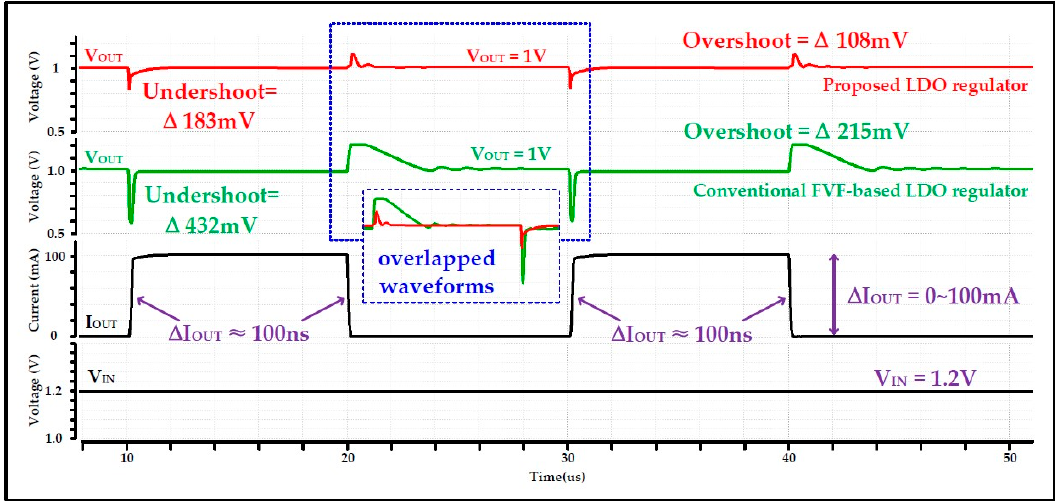
Figure 9. Simulation results of transient responses with load current variations.